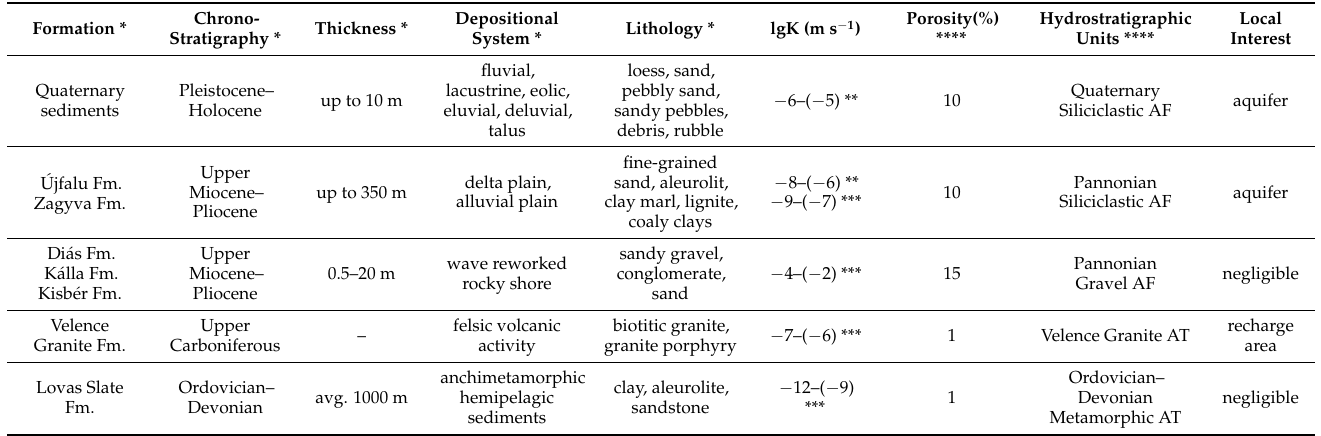
Table 1. Hydraulic properties of the relevant geologic formations in the study